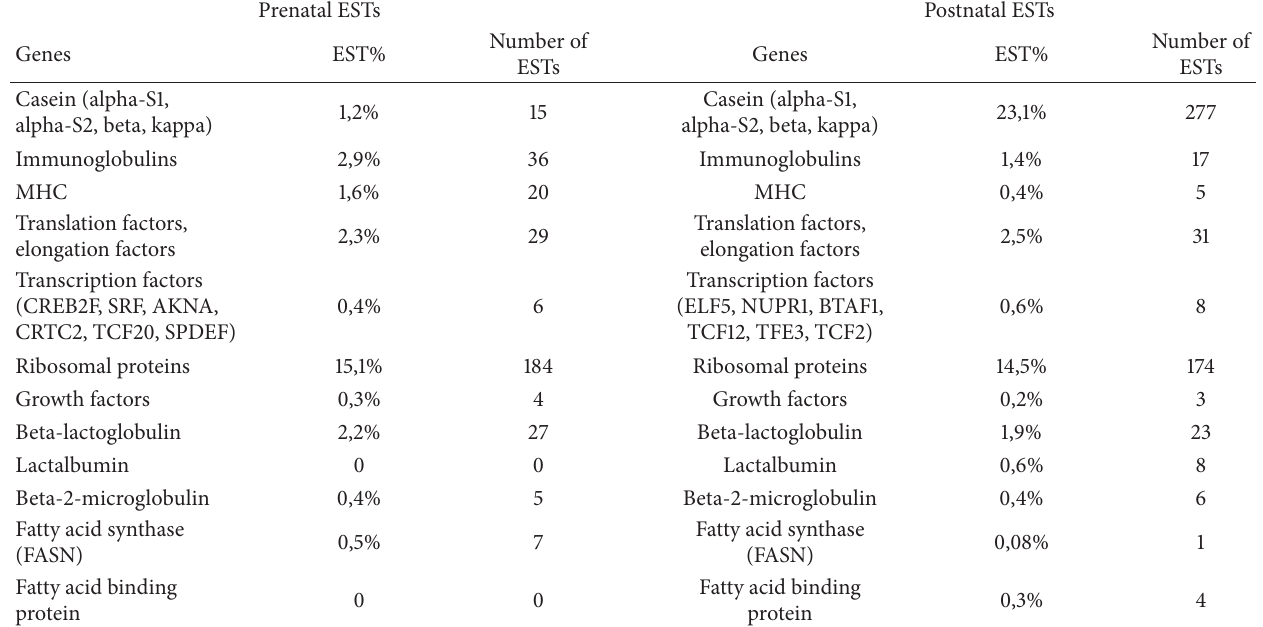
Table 5: The percentage and number of some expressed genes in prenatal and postnatal